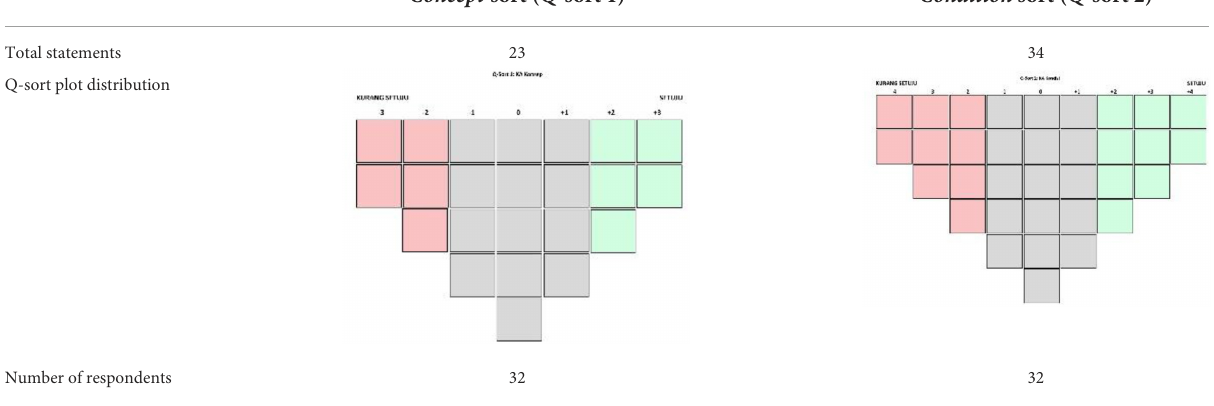
TABLE 3 Q-sort summaries.